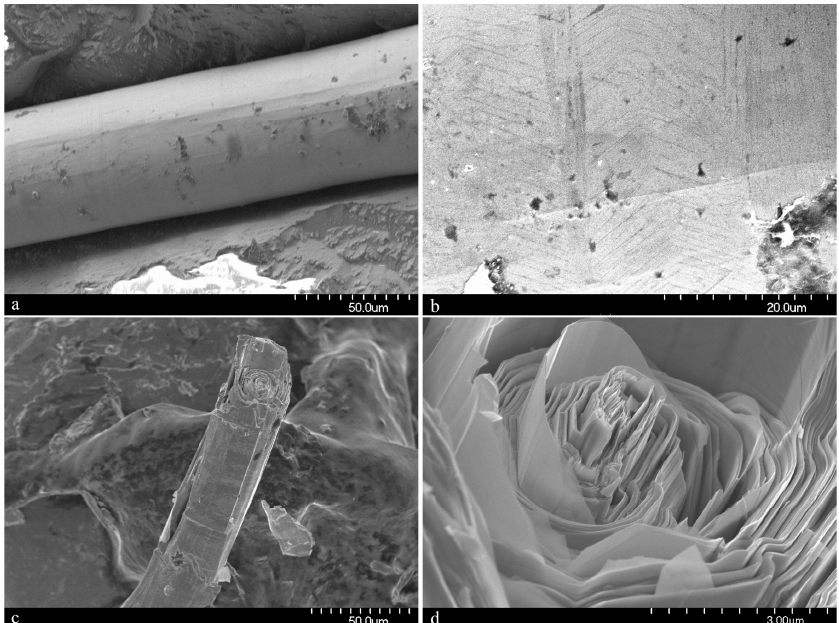
Figure 5. SEM (Hitachi S-4700) images of merelaniite (Smithsonian Institution specimen NMNH 177015, reference 3323). ( a ) Merelaniite cylinder partially exposed from enclosing calcite; ( b ) Close-up image of the surface showing visible growth-layer steps; ( c , d ) The same merelaniite whisker after being broken, showing the curved lamellar (scroll) structure.